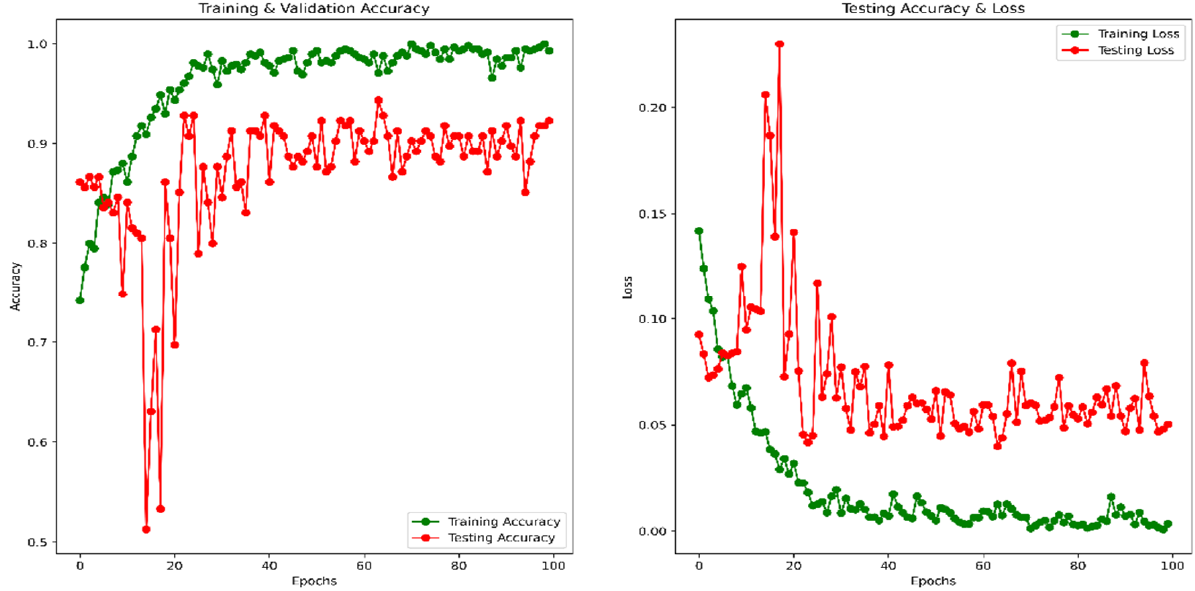
Figure 12. Accuracy and Loss vs Epoch for a combined image in classification.